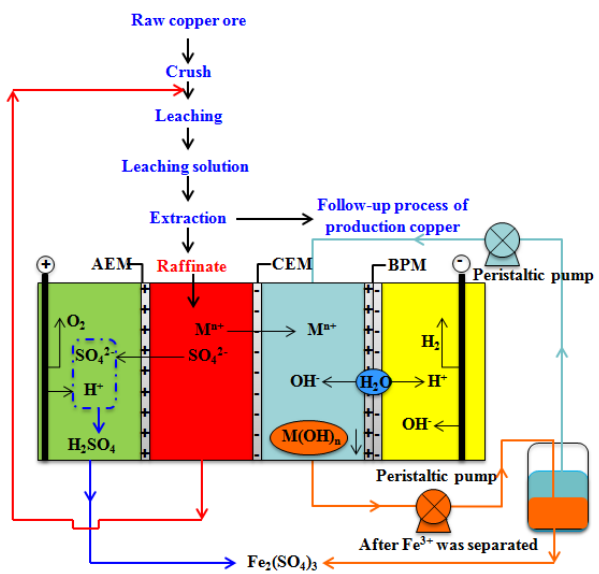
Figure 17. Schematic representation of the BMED experimental setup for treating raffinate. AC, an- ode chamber; RC, raffinate chamber; HMC, heavy metal chamber; CC, cathode chamber; AEM, an- ion-exchange membrane; CEM, cation-exchange membrane; BPM, bipolar membrane [107].